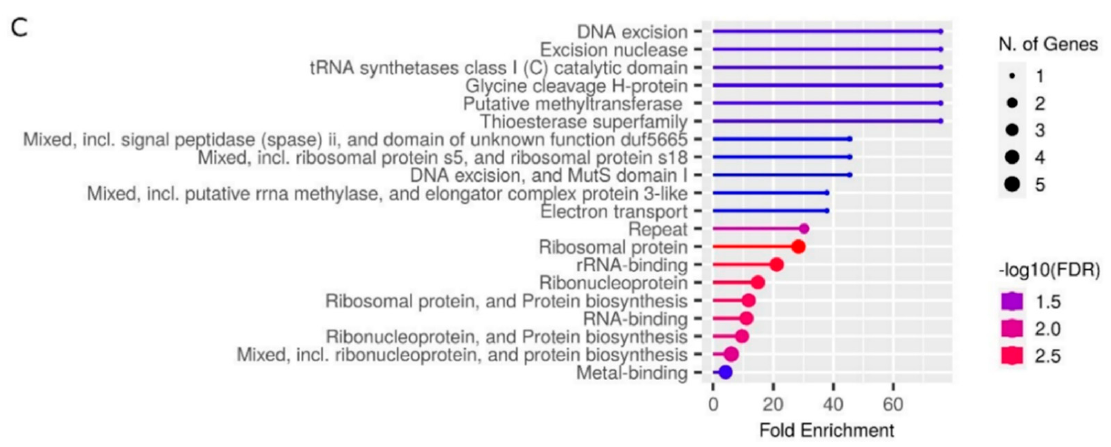
Figure 6. Prokaryotic genes coding for proteins containing GIP-9-like motifs. All-available gene set analysis of ( A ) Desulfotomaculum guttoideum , ( B ) Bacillus selenitireducens , and ( C ) Clostridium ami- nophilum genes. Categories are ranked by fold enrichment order; that is, the percentage of genes in the list belonging to each category divided by the corresponding percentage in the background. Fold enrichment indicates how drastically genes of a certain pathway are overrepresented. N. of Genes indicates the number of genes for each category.